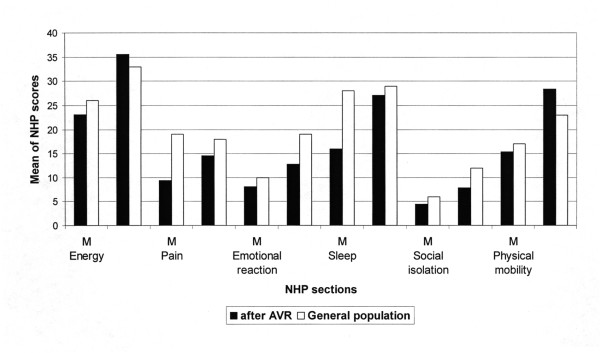
Mean scores of the six NHP sections compared to the age- and gender-matched general German population. The QoL after AVR with the stentless bioprosthesis over the follow-up time was compared to the general German population of the same age and gender. Besides from the section "pain" the patients after AVR showed no significant differences to the normal population. Our observation that the patients after AVR have lower values for pain may be explained by misunderstanding of the questionnaires: the patients thought that the question asking for pain mean only cardiac related pain, whereas in the general population all other kinds of pain were included.